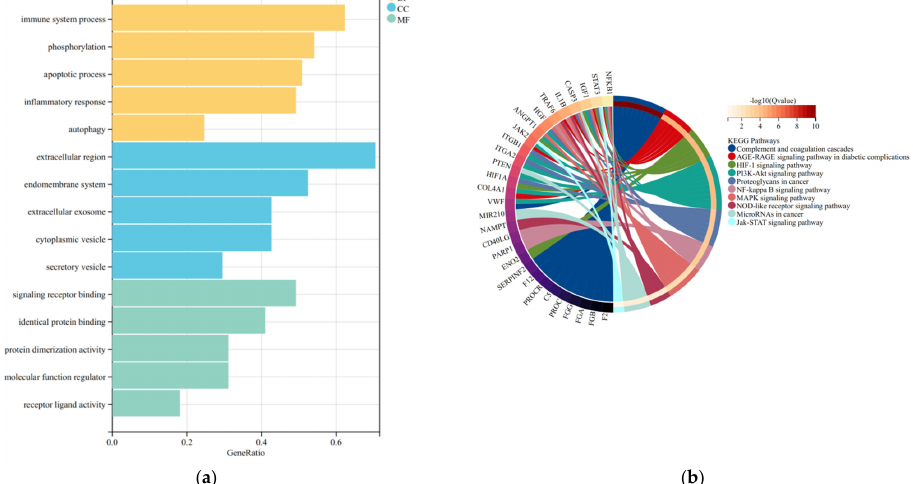
Figure 3. GO and KEGG pathway enrichment analyses of IS-DEGs. ( a ) The bubble plot showing the three aspects of enriched biological processes of biological process (BP), cell component (CC), and molecular function (MF), such as immune response and inflammatory response. ( b ) The chord plot showing the top 10 most enriched KEGG pathways of IS-DEGs. The screening criterion for significantly enriched biological processes and pathways was Q < 0.05. The Q value is the adjusted p